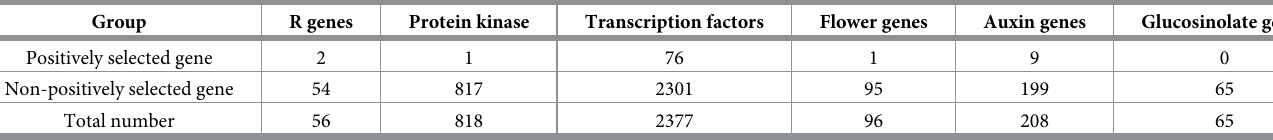
Table 1. The number of positively selected genes and their proportion in the six gene families. Group